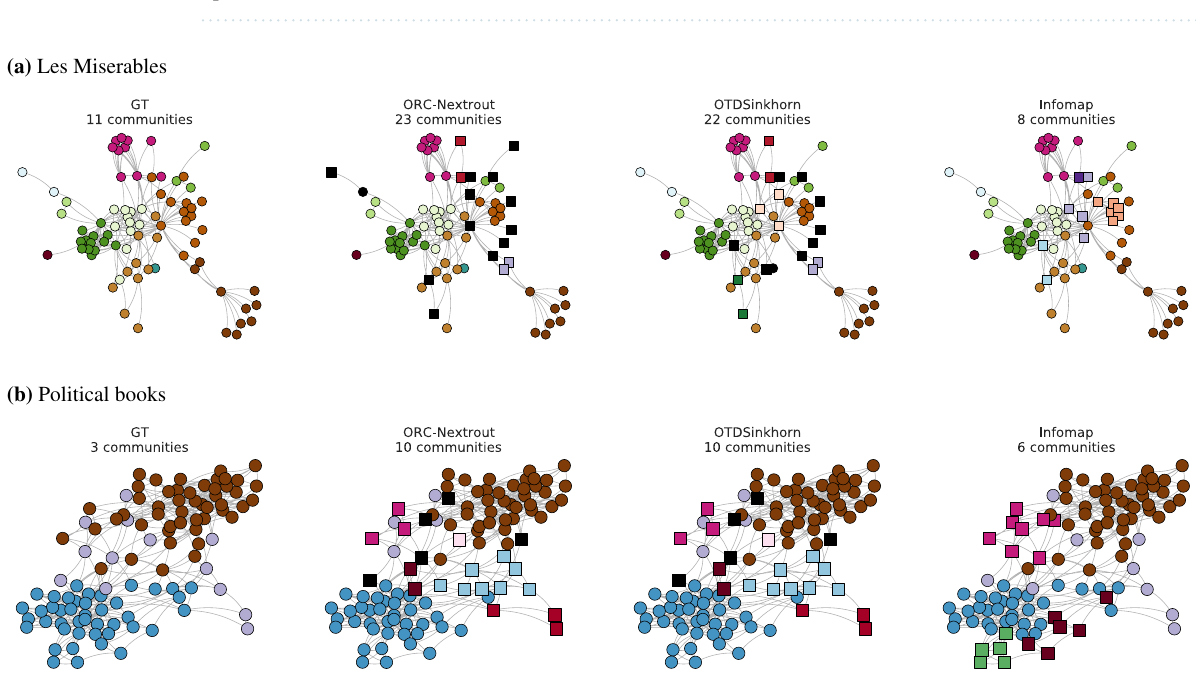
Figure 6. Communities in real networks. We show the communities inferred for Les Miserables ( a ) and Political books ( b ) by ORC-Nextrout ( β = 0.5, 0.1 for top and bottom rows respectively), OTDSinkhorn and Infomap and compare against those extracted using node attributes (GT). The visualization layout is given by the Fruchterman-Reingold force-directed algorithm 73 , therefore, groups of well-connected nodes are located close to each other. Dark nodes represent individual nodes who are assigned to isolated communities by OT-based methods. Square-shaped markers denote nodes assigned to communities different from those obtained from node